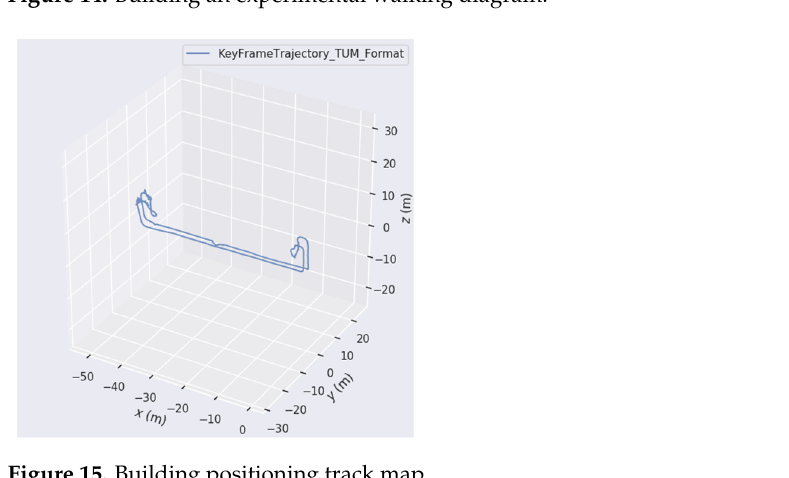
Figure 14. Building an experimental walking diagram.